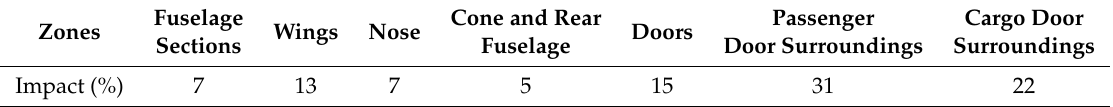
Table 1. Global percentages of impacts by zones of the aircraft